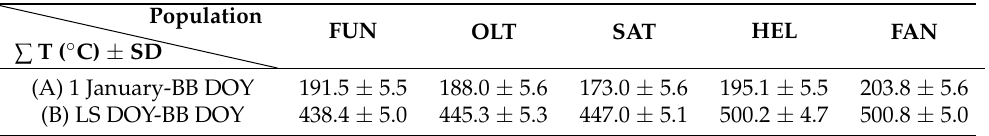
Table 4. Average daily temperature summed from 1 January to budburst (A) and from LS in the previous year until BB in the current year (B).